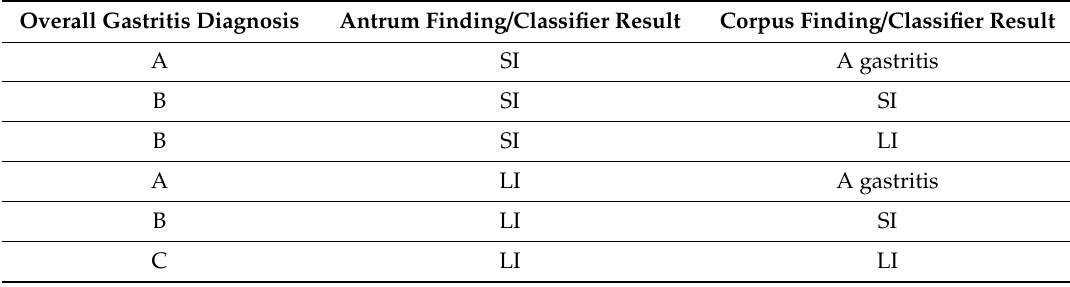
Table 5. Nomenclature of the extracted image patches and encoding of gastritis diagnosis. Overall Gastritis